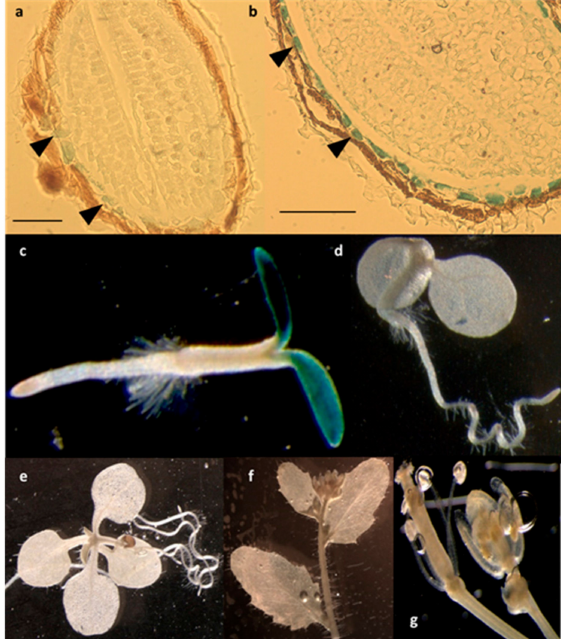
Figure 4. Spatial expression patterns of LPIAT in transgenic Arabidopsis harbouring the LPIAT promoter fused to the β -glucuronidase (GUS) gene. Promoter activity was visualized by histochemical GUS staining on ( a ) dry seed, ( b ) imbibed seed, ( c ) 2-day-old seedling, ( d ) 4-day-old seedling, ( e ) 9-day-old seedling, ( f ) cauline leaves and inflorescence, ( g ) flower. Scale bar: 100 µ m. Arrow heads in (a) and (b) show cells from the aleurone-like